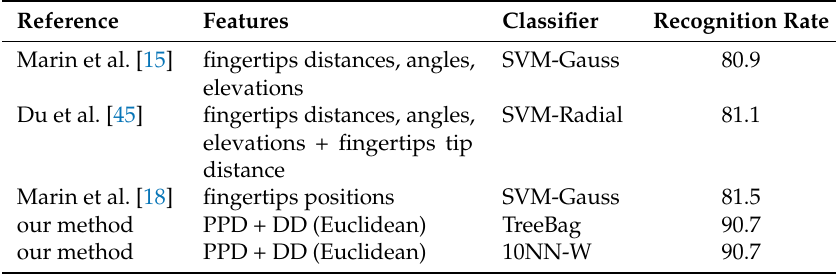
Table 6. Comparison of leave-one-subject-out, 14-fold cross-validation test results obtained for Dataset 2.